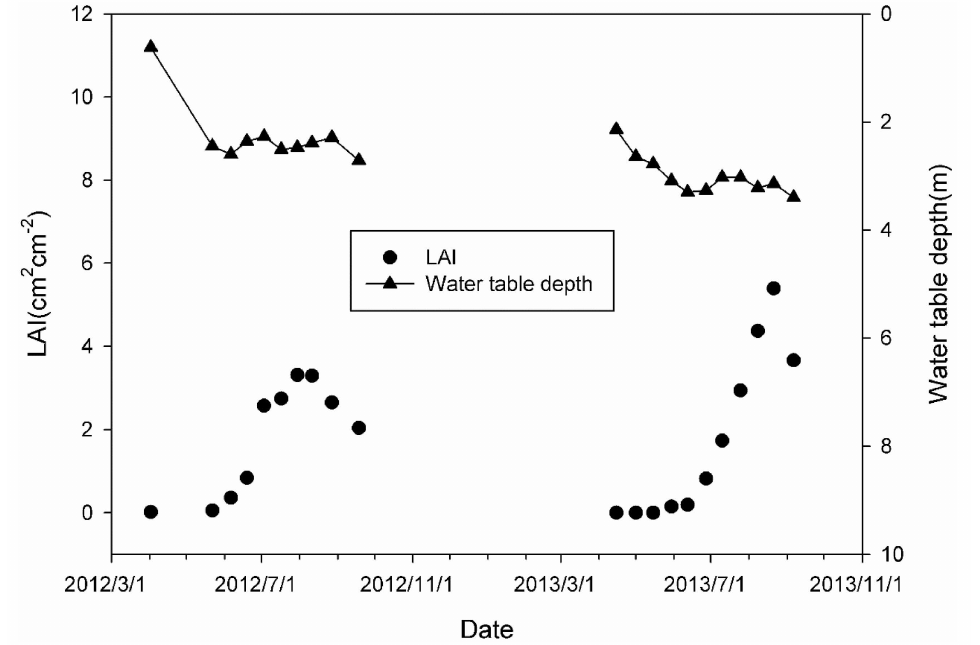
Figure 3. LAI and water table depth during the growing season for two